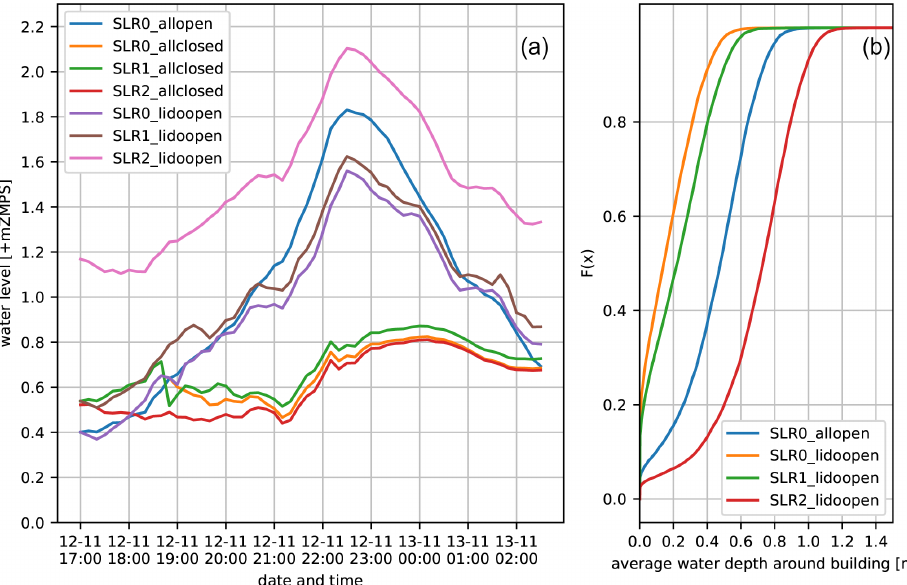
Figure 9. Flood depths for scenarios. (a) Modeled flood peaks at Punta della Salute. MOSE barrier activation for the different scenarios was 12 November 2019 18:40 (SLR0), 12 November 2019 18:10 (SLR1), or 11 November 2019 18:10 (SLR2) according to Table 4. (b) Share of buildings exposed to certain average flood depths. Table 10. Flood peak level at Punta della Salute [m ZMPS] and damage estimates [EUR million] for different scenarios. d3dfm Bathtub Scenario Peak Risk-averse Medium Risk-taking Risk-averse Medium